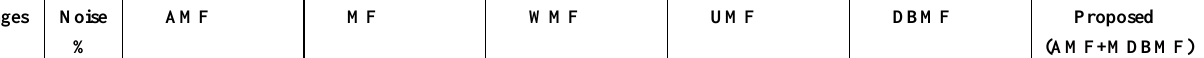
Table 1. Results of non-linear filters on both standard images and medical images affected by salt & pepper noise. Images